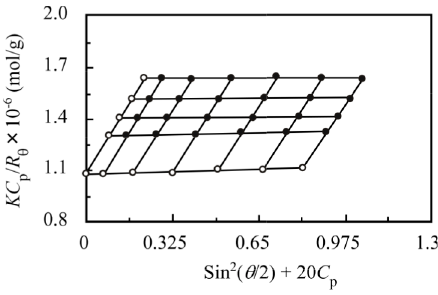
Figure 7. Zimm plot for the PNaSS 58 – b –PAA 125 /PNaSS 58 – b –PNIPAM 115 complex with f NIPAM = 0.5 in 0.1